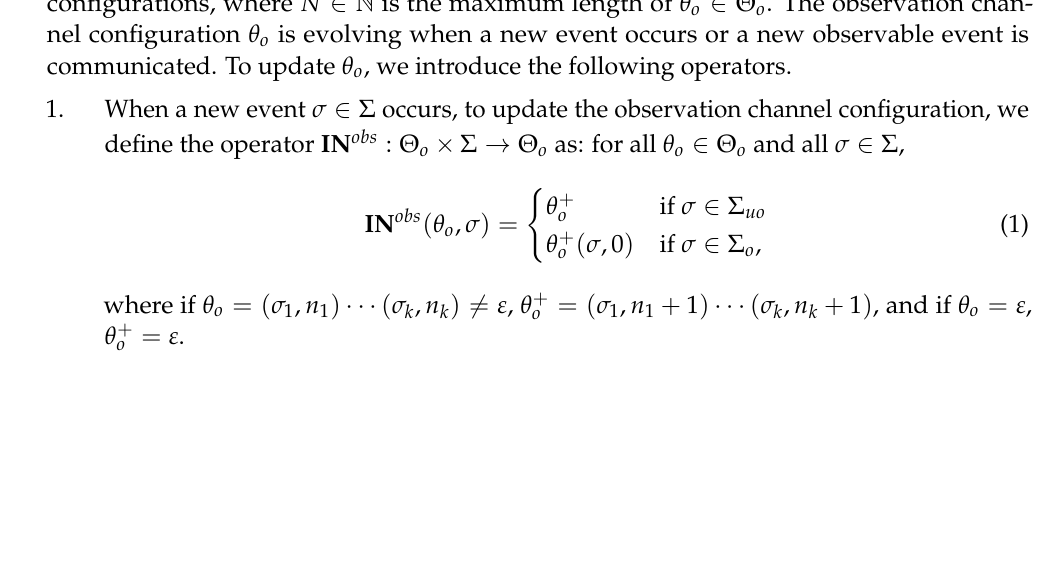
Figure 2. System G and Supervisor S = ( A , χ )